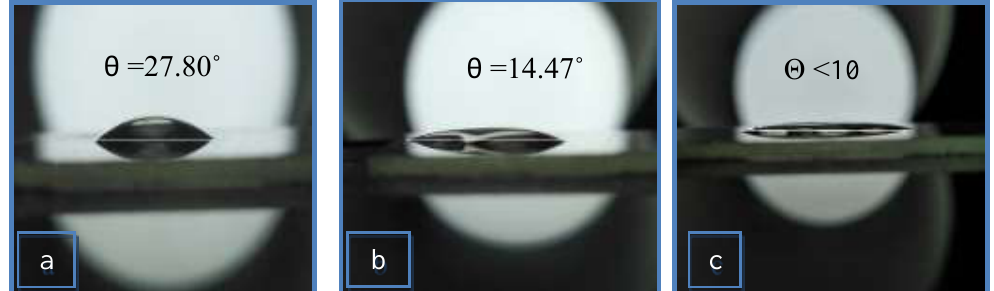
Fig.01b: Images of water droplet on the sample pure TiO b- after15 min. of Vis irradiation c- an hour Vis irradiation.